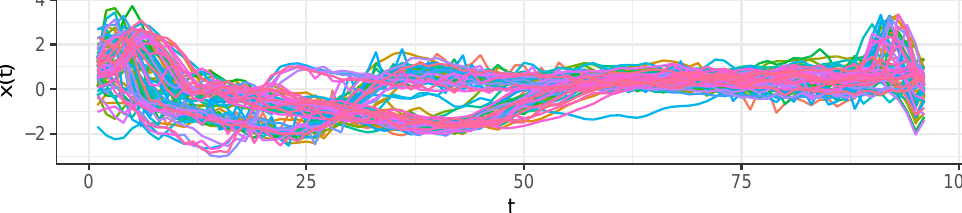
D: The 72(!) observations labeled as outliers based on MS−Plot